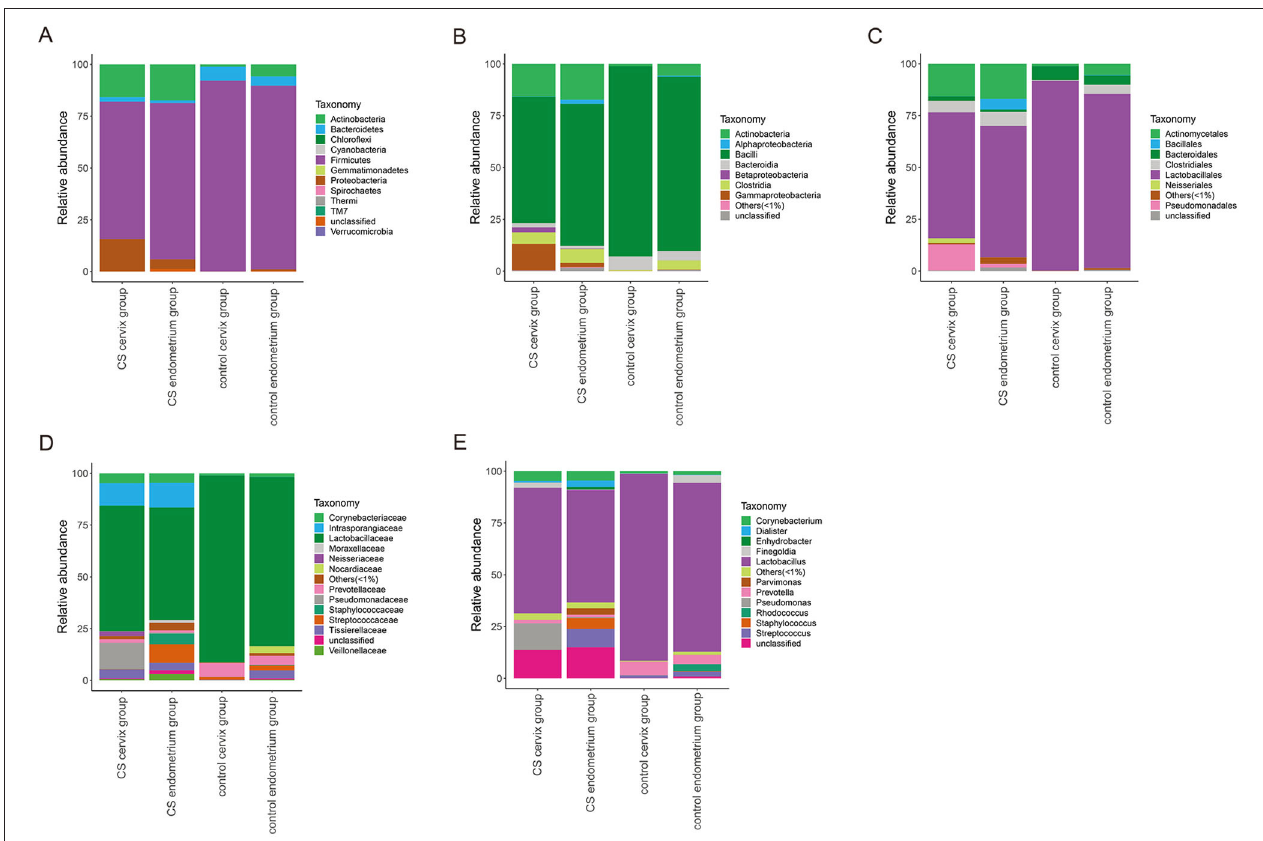
FIGURE 4 | The relative abundance of microbial flora at the phylum-class-order-family-genus level. The relative abundance of species at the phylum (A) , class (B) , order (C) , family (D) , and genus (E) levels. The figure shows the species with a relative abundance of ≥ 1%. The abundance was lower than 1%, and those classified as unclassified or unidentified were classified as